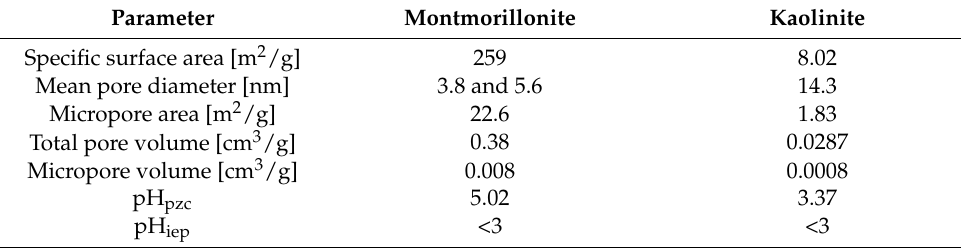
Table 1. Textural characteristics of the examined